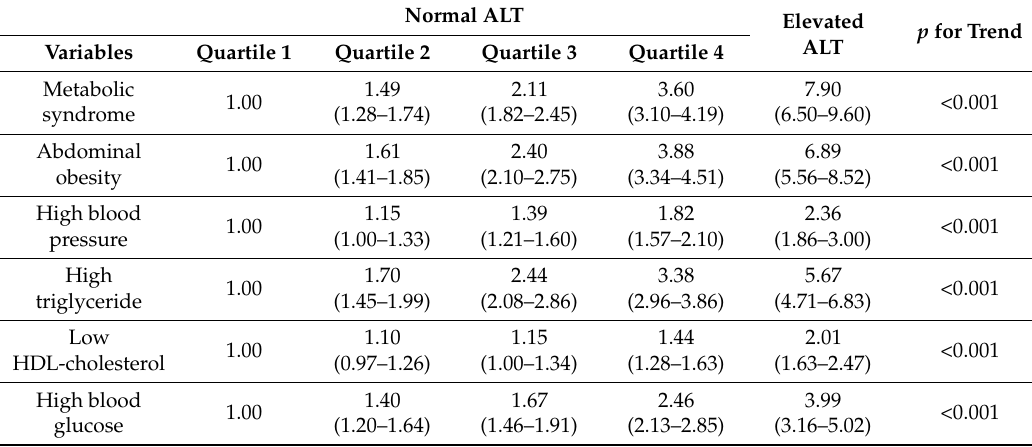
Table 3. Odds ratios (95% confidence interval) for metabolic syndrome and components by the level of liver